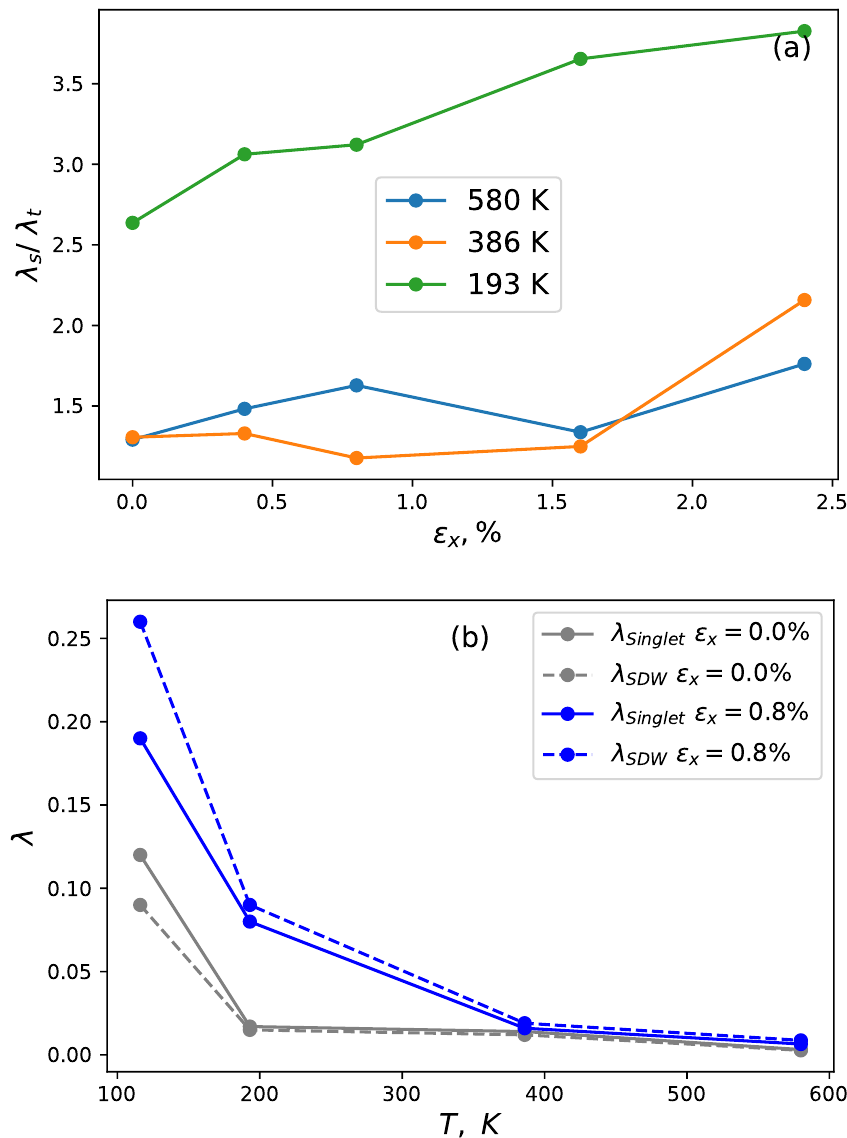
Figure 5. Superconducting eigenvalues: singlet-triplet scale separation and SDW: ( a ) We plot the relative strength of the leading singlet eigenvalue in comparison to the triplet eigenvalue ( λ s / λ t ) extracted by solving the multi-orbital Bethe–Salpeter equation in the superconducting channels (both singlet and triplet) as functions of temperature. With strain, λ s / λ t increases, and the trend becomes more prominent with decreasing temperature. ( b ) In the unstrained compound, the leading eigenvalue ( λ s ) singlet superconducting instability has a slightly steeper temperature dependence in comparison to the eigenvalue ( λ SDW ) for the SDW instability. However, under strain, beyond (cid:101) x = 0.6%, the SDW instability becomes the leading instability of the system upon lowering tempera-